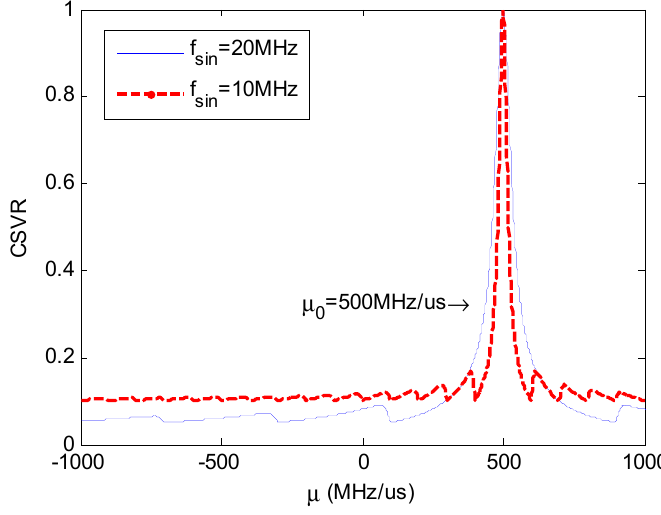
Figure 6. CSVR spectrum using different (cid:1858) (cid:2929)(cid:2919)(cid:2924) .